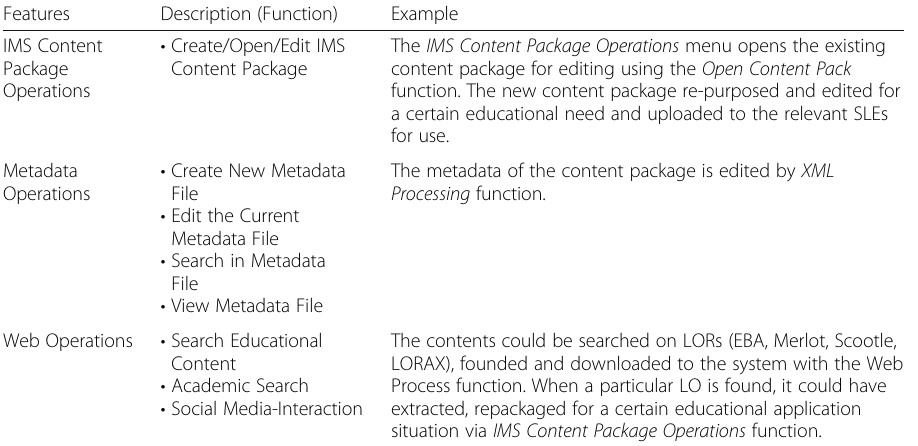
Table 3 Functions and features in